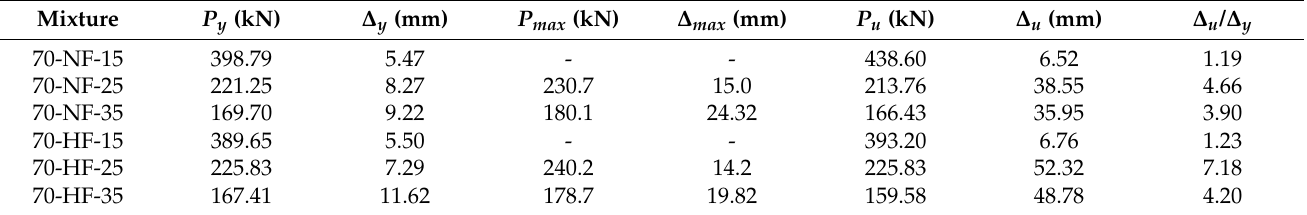
Table 5. Effects of Fiber Tensile Strength and Span Ratio on Yield Load and Ultimate Load of Steel Fiber-Reinforced Concrete Beam